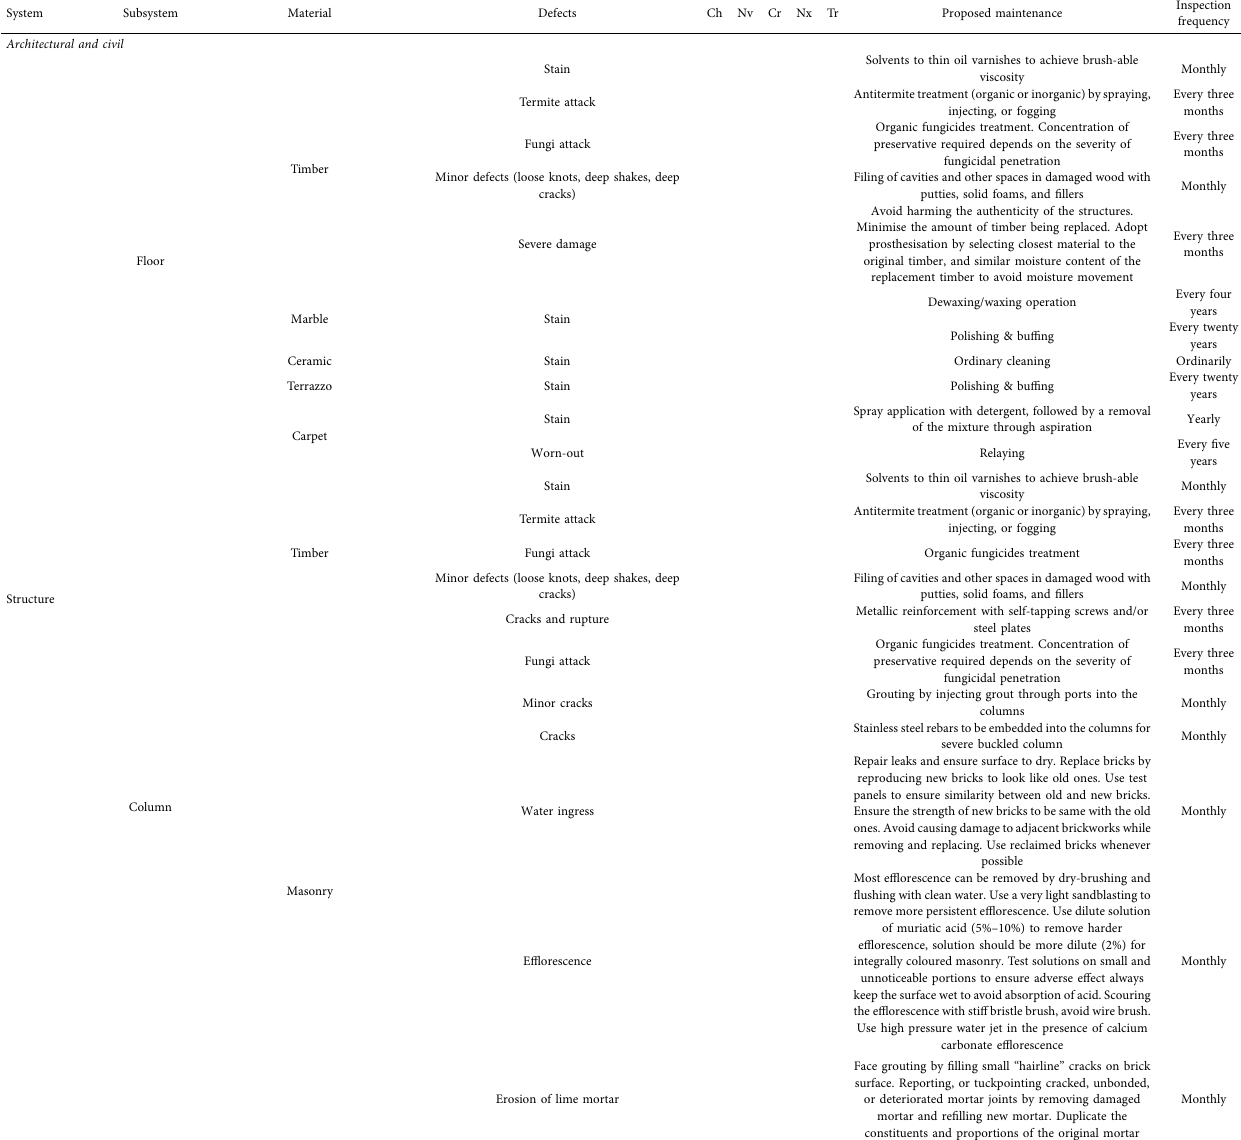
Table 10: Proposed maintenance plan for Anglican churches in